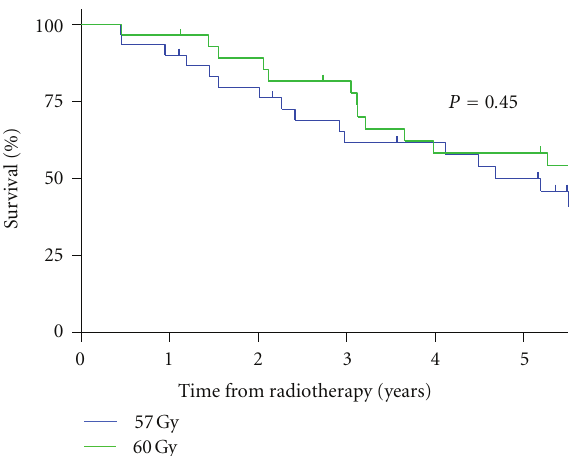
Figure 1: Kaplan-Meier estimates for overall survival for the two radiotherapy fractionation schedules, 57 Gy in 19 fractions and 60Gy in 20 fractions.